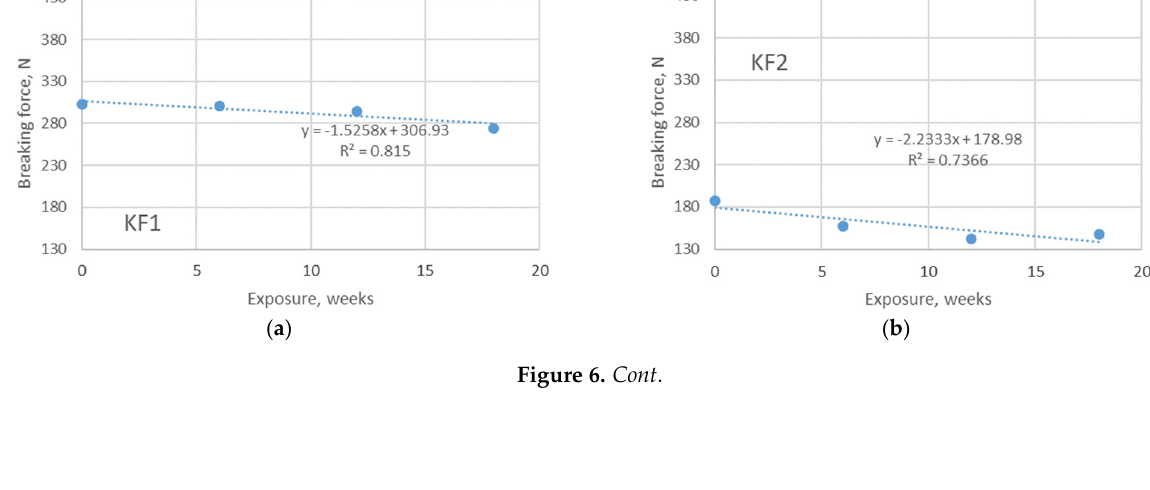
( d ) Figure 6. Breaking force of materials exposed to aging in pool water, indoors. The overview is given for: ( a ) material KF1; ( b ) material KF2; ( c ) material KF3; ( d ) material KF4. Materials made using knitting technology are known to have improved comfort properties, especially when elastane yarns are also used for plating. The previously pub- lished researches showed that the content of elastane in the material structure has a sig- nificant influence on the elastic properties (primary elastic recovery) of the materials [25,26]. The results of the measured breaking elongation of the investigated materials con- firmed this evidence. More precisely, the breaking elongation of non-aged polyester ma- terial without elastane component is only 182 N, while the breaking elongation of the pol- yester material with the addition of 15% of elastane component increases by 52% (Figure 7). The effect of smaller differences in elastane content (in this case 20% and 22%, respec- tively, as defined in Table 1) has no effect on the changes in breaking elongation that can be considered significant. The experiment presented in this study provided insight into the changes of breaking forces due to aging. Unlike the breaking force, the breaking elon- gation does not decrease with the same trend over the exposure time. The graphs pre- sented in Figure 7 show a decrease of breaking elongation with increasing exposure du- ration. The coefficients describing this relationship range from 0.55 to 0.87, mostly indi- cating a medium correlation. The graphs shown in Figure 8 indicate that there is no uni- form change in breaking elongation when the materials are aged indoors. This primarily relates to polyester materials where the relationship between the observed variables (breaking elongation and exposure duration) is very weak (R 2 is 0.0012 and 0.0167 respec- tively). These results led to the conclusion that the chemicals and pool water do not affect the changes in the breaking elongation of the materials in the same way that exposure to sunlight does. When the measured values of breaking elongation are placed directly in the context of the measured mass per unit area (through correlation coefficients shown in Table 6), it can be seen that the change in breaking elongation strongly follows the changes in mass per unit area (the correlation coefficient is 0.867). In terms of comfort assurance, the results showed that outdoor aging of materials should have a stronger negative effect than aging indoor.